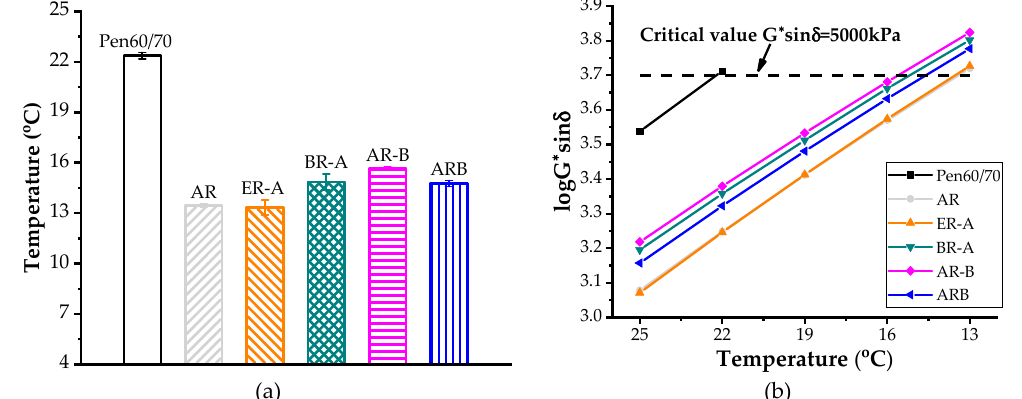
Figure 4. Fatigue performance of asphalt binders: ( a ) failure temperatures and ( b ) logarithm of G * sin δ values.